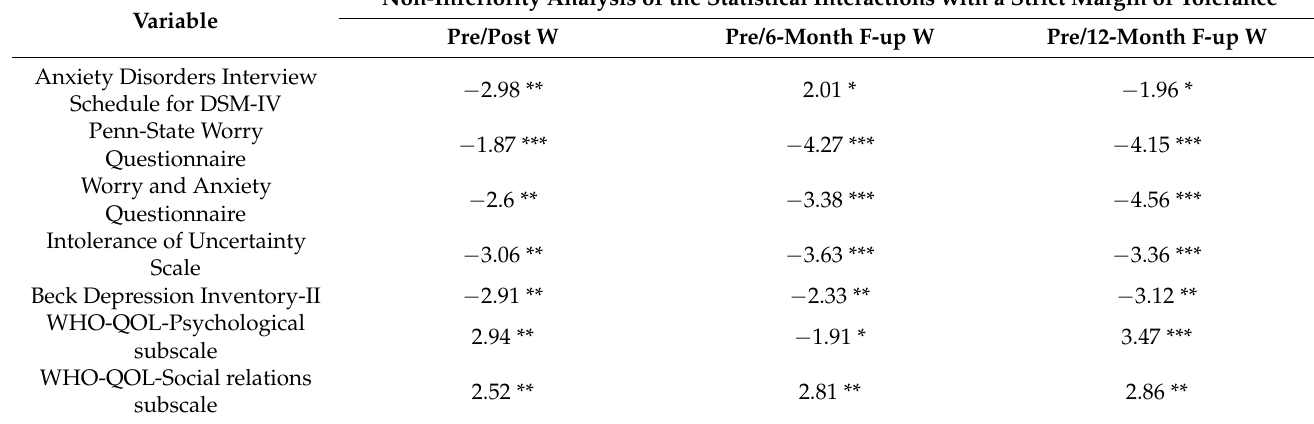
Table 4. Non-inferiority analyses for participants who completed the treatment ( n =